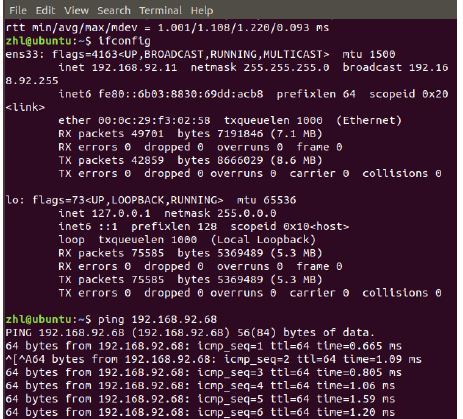
Figure 6. Ping the address of Raspberry Pi via virtual machine. In order to keep track of the status of each device, occupancy numbers are saved as ‘.csv’ files in both the virtual machine and physical hardware. The server (virtual machine 1) not only plots the data but also saves the data on its own hard disk. Such data will be distributed to other clients for further processing/control. Moreover, an HVAC control machine (virtual machine 2) is also established. The SCP is used to obtain the data from the server (virtual machine 1); afterwards, it uses the data for HVAC